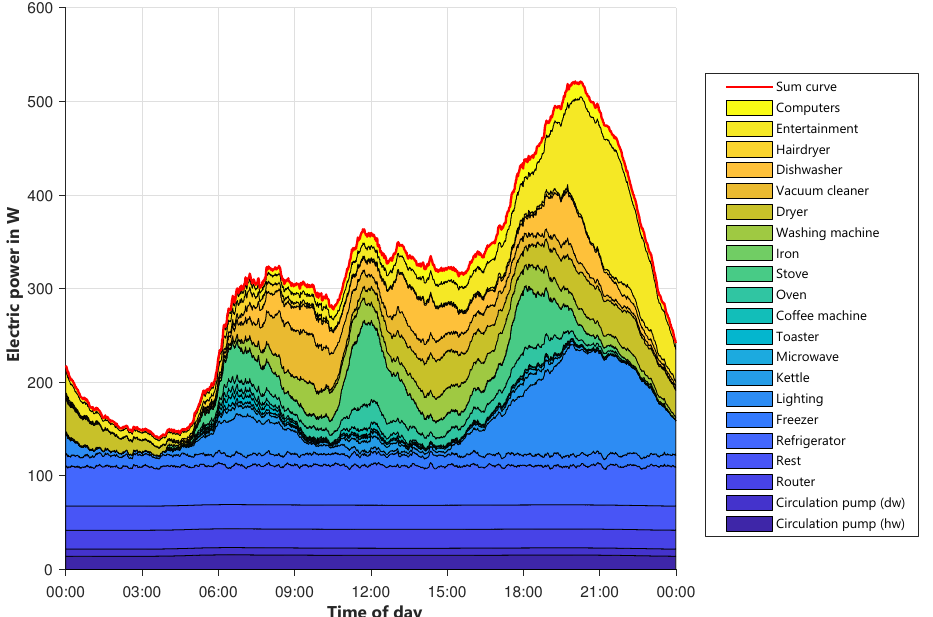
Figure A5. Layered load profiles of devices for type of day Friday.